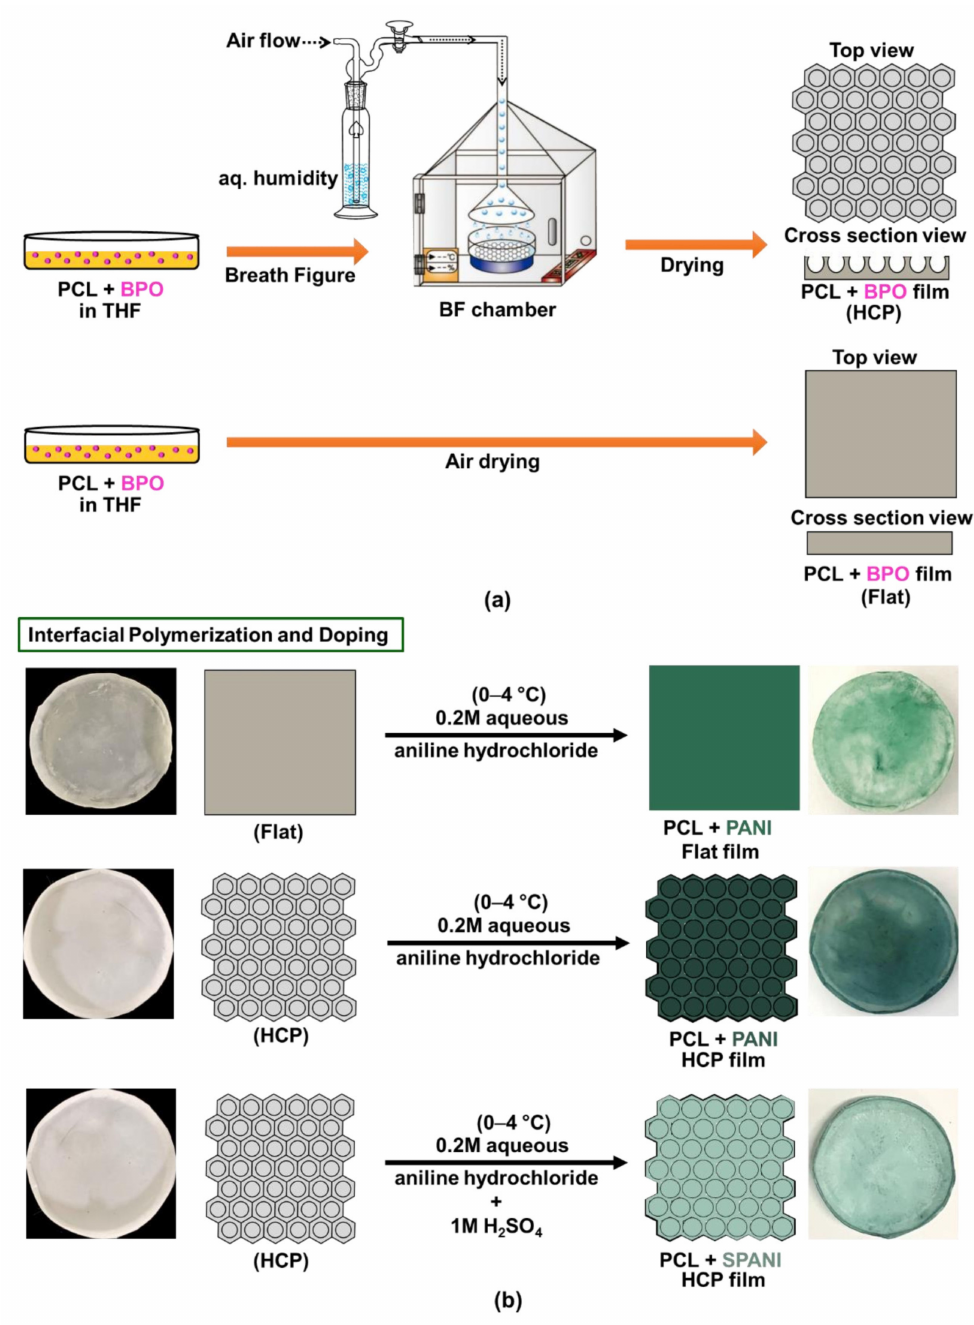
Figure 1. The overall scheme of PANI functionalization. ( a ) Fabrication of HCP ( top ) and flat ( bottom ) PCL films. ( b ) Interfacial polymerization of PANI at the surface of flat ( top ), HCP ( middle ), and sulfonated HCP ( bottom ) films with their corresponding photo